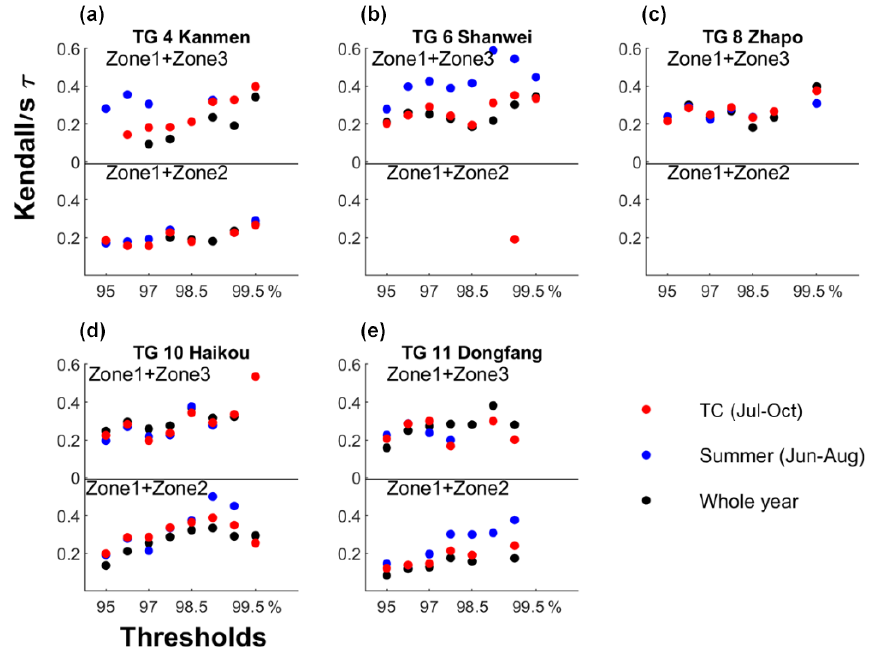
Figure 5. Kendall dependence between storm surge and precipitation in summer, the TC season, and the whole year for thresholds running from 95% to 99.5%. (a) Kanmen (TG4); (b) Shanwei (TG6); (c) Zhapo (TG8); (d) Haikou (TG10); (e) Dongfang (TG11).